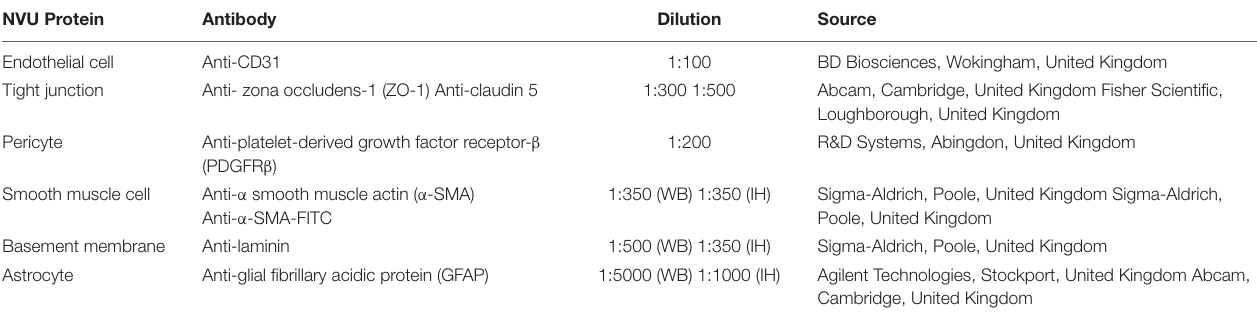
TABLE 1 | Antibodies used in Western blotting (WB) or immunohistochemistry (IH) to label the NVU. NVU Protein